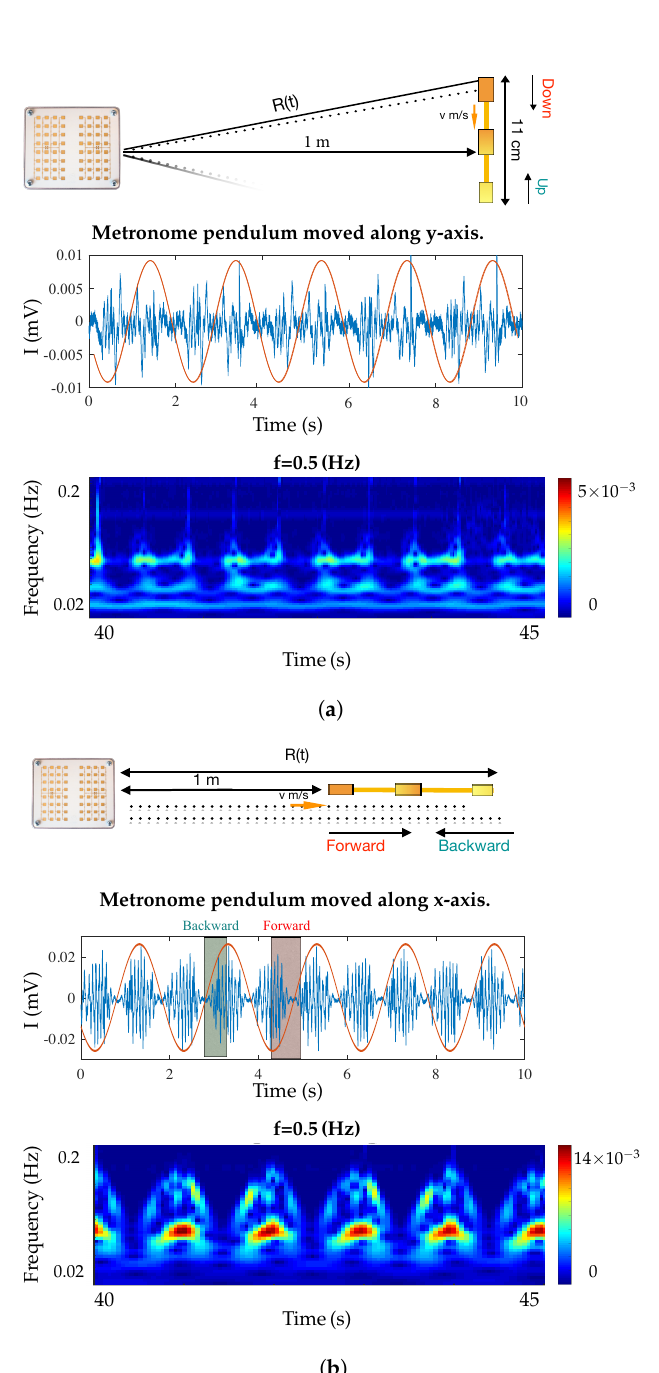
Figure 3. Baseband signals reflected from metronome while its pendulum is oscilated along x and y axis. ( a ) Wavelet scalograms of baseband signals for metronome pendulum moved along y -axis. ( b ) Wavelet scalograms of baseband signals for metronome pendulum moved along x